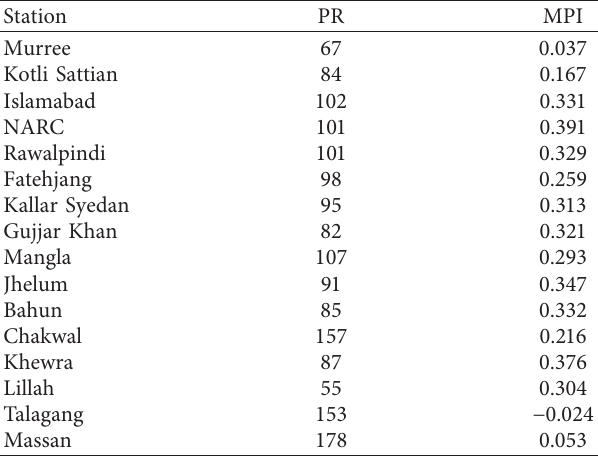
Table 6: Precipitation ratio and monsoon precipitation index of rainfall